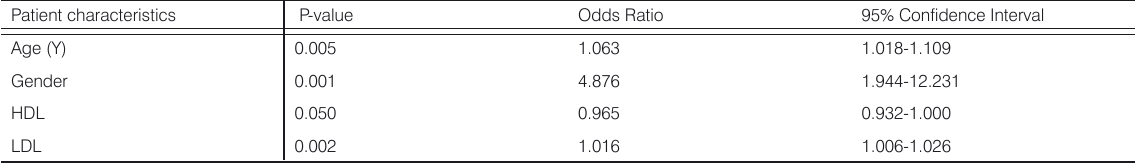
Table 4. Predictive factors of CAD between